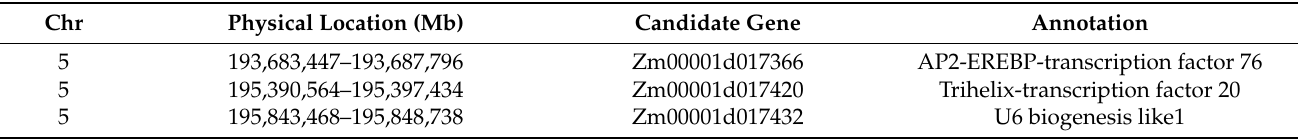
Table 6. Putative candidate genes for maternal haploid